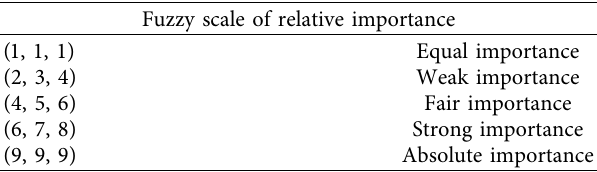
Table 7: Fuzzy scale of relative importance.